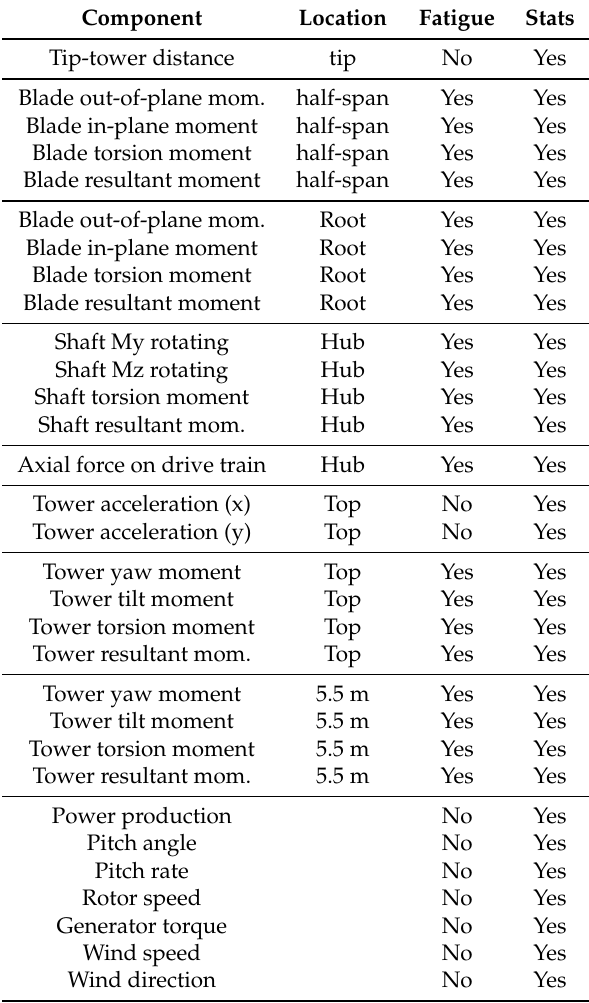
Table 1. Signals stored in the loads